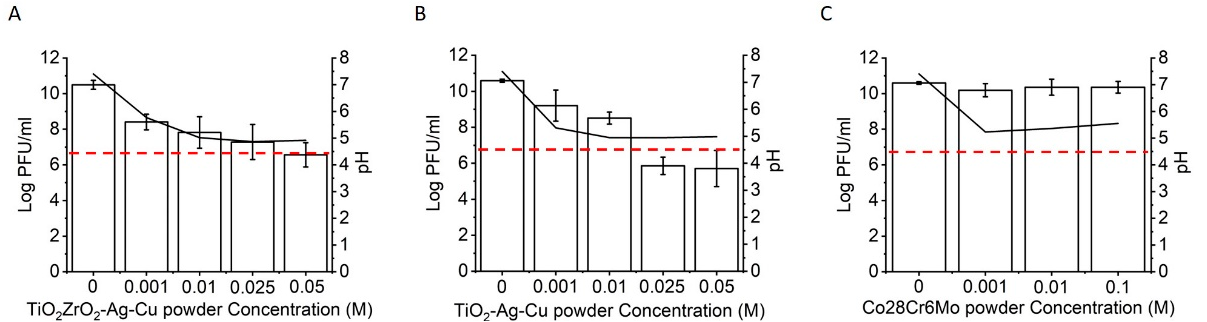
Figure 3. Phi6 viral titers after treatment with metal/ceramic powder suspensions. ( A ) Phi6 treated with TiO 2 –ZrO 2 –Ag–Cu powder; ( B ) TiO 2 –Ag–Cu powder; ( C ) Co28Cr6Mo metal powder. Black lines represent the pH of the ceramic–metal suspensions, and red dashed lines indicate the decrease in viral titer by 99.99% compared to the control. The average values and standard deviations are shown (n ≥ 3).